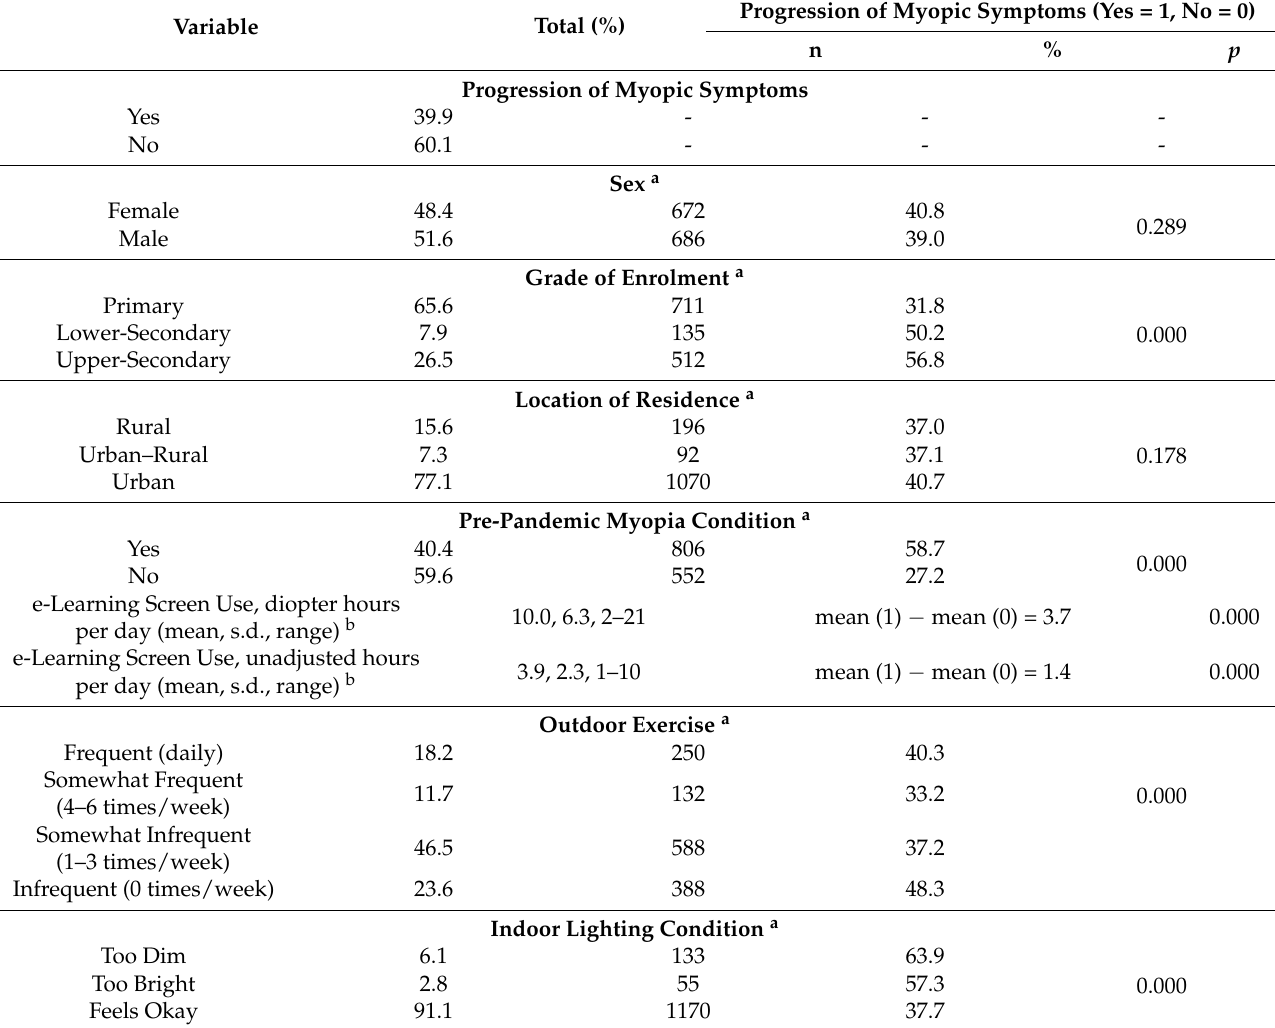
Table 1. Univariate parametric and nonparametric